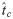
Distributions of log10(t^c) values for singleton variants from each 1KGP population.